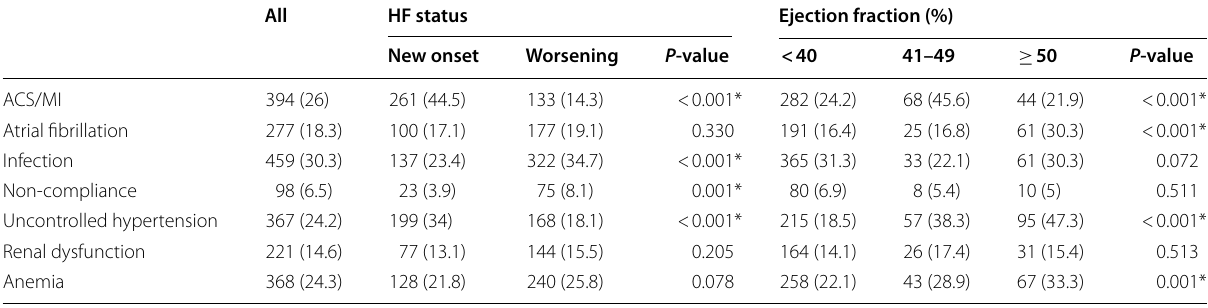
* Significant; Data were presented as number (percentage) ACS/MI Acute coronary syndrome/Myocardial =